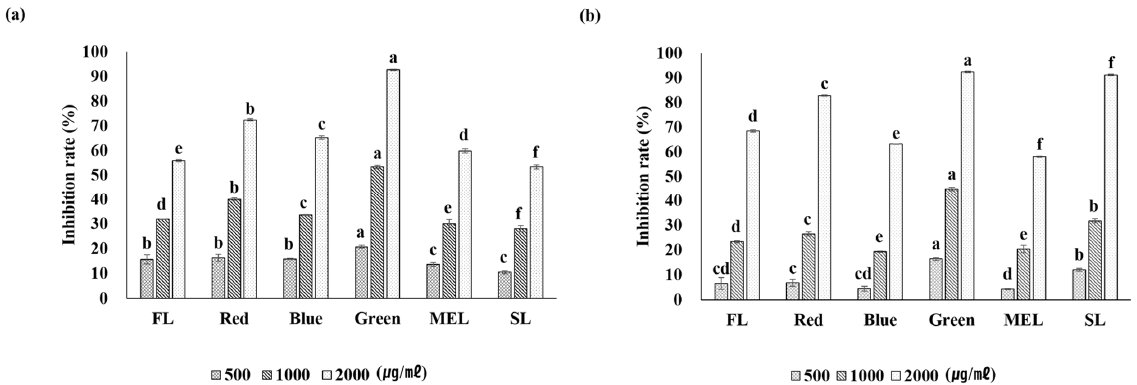
Figure 2. The inhibition rate of DPPH free radical scavenging activities of aerial ( a ) and under-ground ( b ) parts from extracts of Dachul under different light sources. Values represent mean of data obtained from three independent experiments ( p < 0.05).